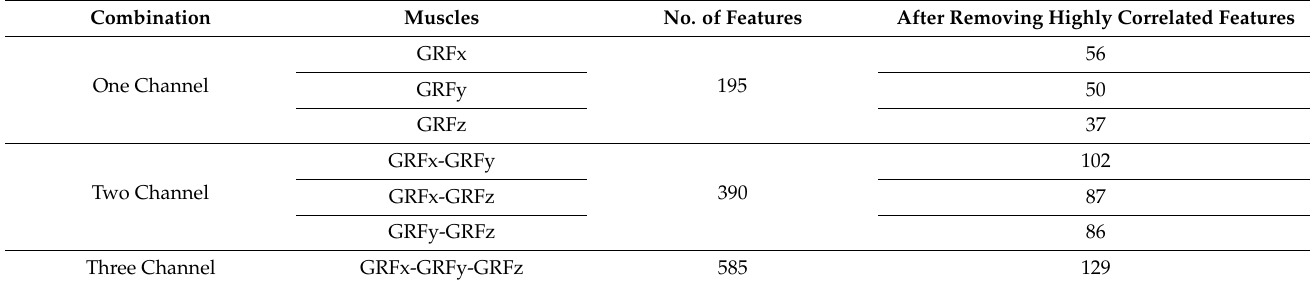
Table 6. Number of features extracted from GRF for a different combination.